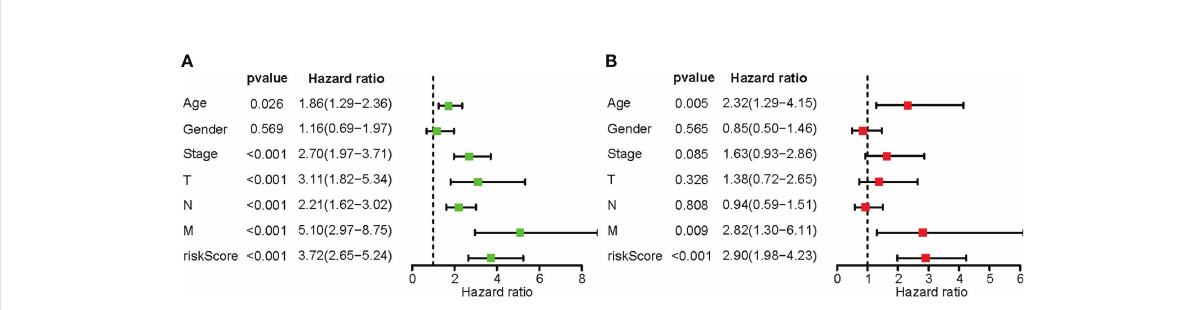
FIGURE 5 The predictive usefulness of clinicopathological features and risk ratings. (A) Univariate Cox regression of colon cancer patients. (B) Multivariate Cox regression of colon cancer